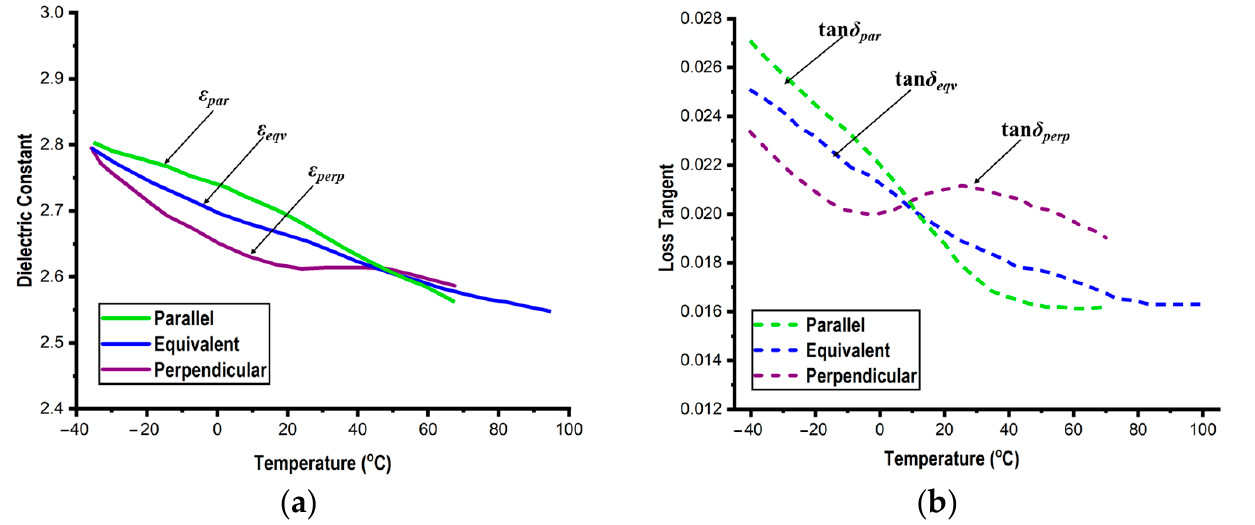
Figure 7. Dielectric parameters: dielectric constants ( a ) and loss tangents ( b ) of PDMS at various temperatures (5–15 GHz). Table 4. Empty resonator (R A and R B ) parameters (units GHz, mm, S/m, ° C) at di ff erent tempera- tures.